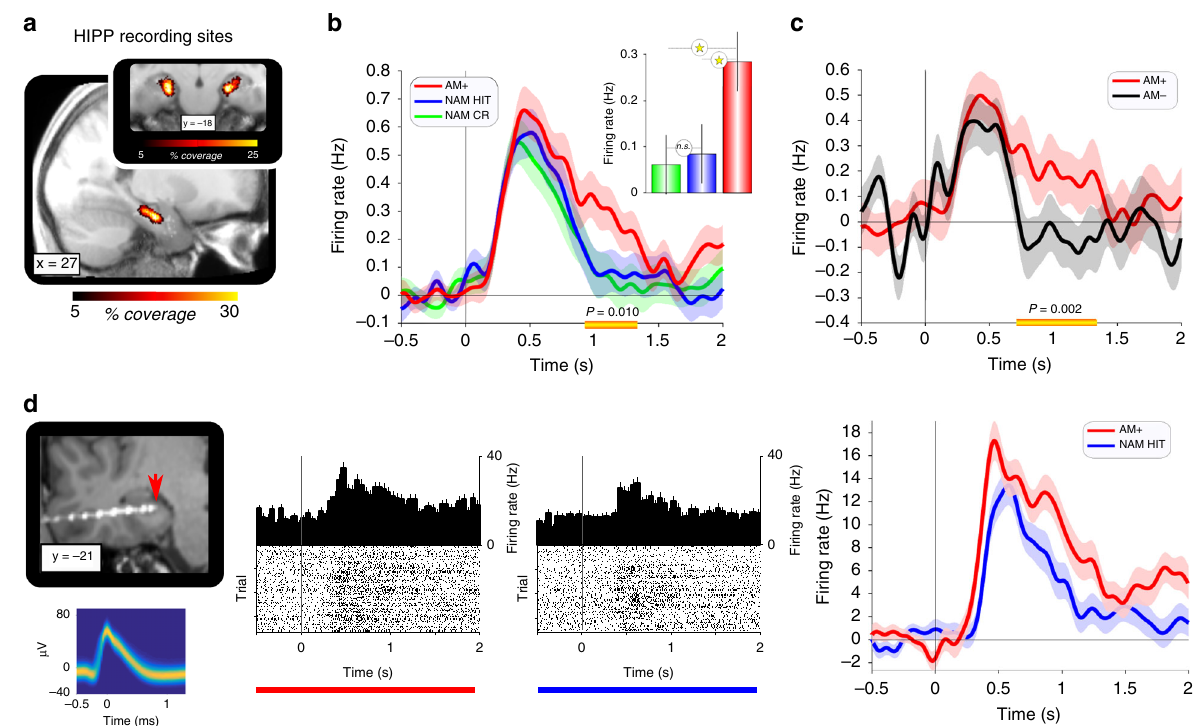
Fig. 2 Hippocampal engagement during successful associative memory retrieval (AM + ). a Hippocampal (HIPP) recording sites across participants projected onto the mean anatomical scan, normalized to MNI space. b Mean HIPP fi ring rates across neurons ( n = 238, baseline-corrected) during successful associative retrieval (AM + ), successful recognition of old images (NAM HIT) and successful identi fi cation of new images (NAM CR). Shaded areas show average standard error of all pairwise condition differences. Horizontal yellow line indicates a signi fi cant cluster of repeated-measures ANOVA Condition effects from 900 – 1300 ms post stimulus onset (corrected for multiple comparisons across the entire 0 – 2000 ms time window; Methods). The cluster P value is .010 and the maximum effect size (F (2,474) ) is 6.37 at 1000 ms. Inset shows results from pairwise follow-up contrasts, revealing a signi fi cant increase in fi ring rates for AM + compared to both nonassociative conditions. c Mean HIPP fi ring rates across neurons ( n = 170, after removing participants with less than 10 AM- trials) during successful vs. unsuccessful associative retrieval (AM + vs. AM − ). Shaded areas show standard error of the condition difference. Horizontal yellow line denotes a signi fi cant cluster of paired-samples t -test effects from 700 – 1300 ms post stimulus onset (corrected for multiple comparisons across the entire 0 – 2000ms time window). The cluster P value is .001 and the maximum effect size (t (169) ) is 3.19 at 780 ms. d Single neuron example. left: participant ’ s electrode placement, illustrated as a post-operative CT scan co-registered to the pre-operative MRI scan and normalised to MNI space. Arrow head indicates protruding microwires. Waveforms of action potentials are depicted as temperature-scaled density plots. middle: graphs show spike raster plots and peri-stimulus time histograms (PSTH, 50 ms bins) for AM + (red) and NAM HITs (blue). right: corresponding time courses (mean ± SEM across trials) after convolving the spike trains with a Gaussian kernel (50 ms width) and subtracting the − .5 to 0 s baseline